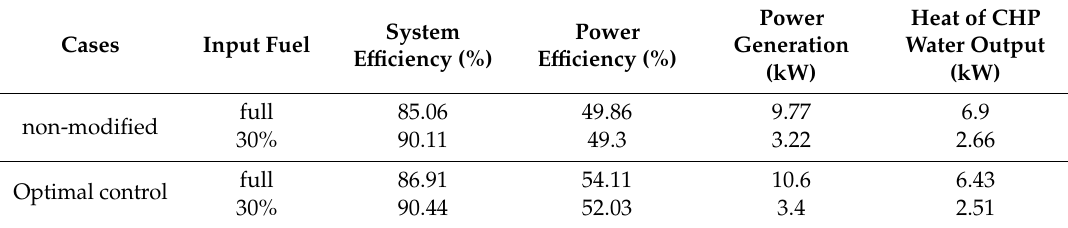
Figure 7. Dynamic curves of the operating current and power generation in long-term SOFC-CHP system operation. ( a ) The non-modified case; ( b ) optimal control case. Table5. PowerandsystemefficiencyoftheSOFC-CHPsystemofatwo-stackmodulewithmaldistribution flow